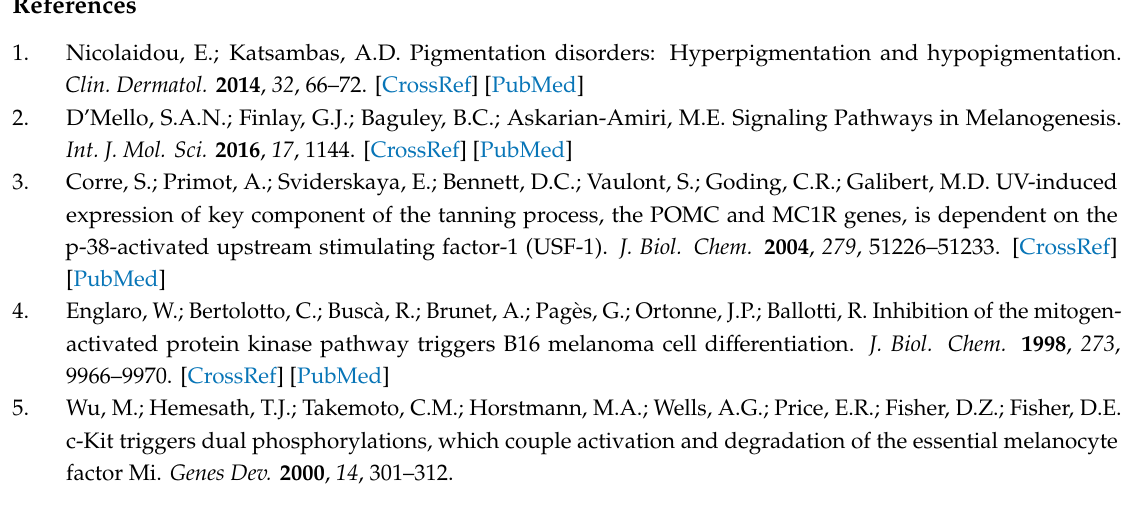
Figure S1: Cytotoxic e ff ect of LEO and REO on dermal cell lines, Figure S2: Inhibitory e ff ect of LEO and REO on melanin content and tyrosinase enzyme activity in FRK-induced B16-F10 melanoma cells, Figure S3: GC–MS analysis of LEO and REO, Figure S4: Cytotoxic e ff ect of test compounds on B16-F10 cells, Table S1: List of antibodies used in this study, Table S2: List of primers used in this